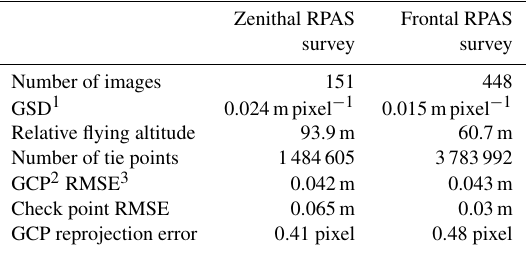
Table 2. Information related to the zenithal and frontal photogram- metric surveys and